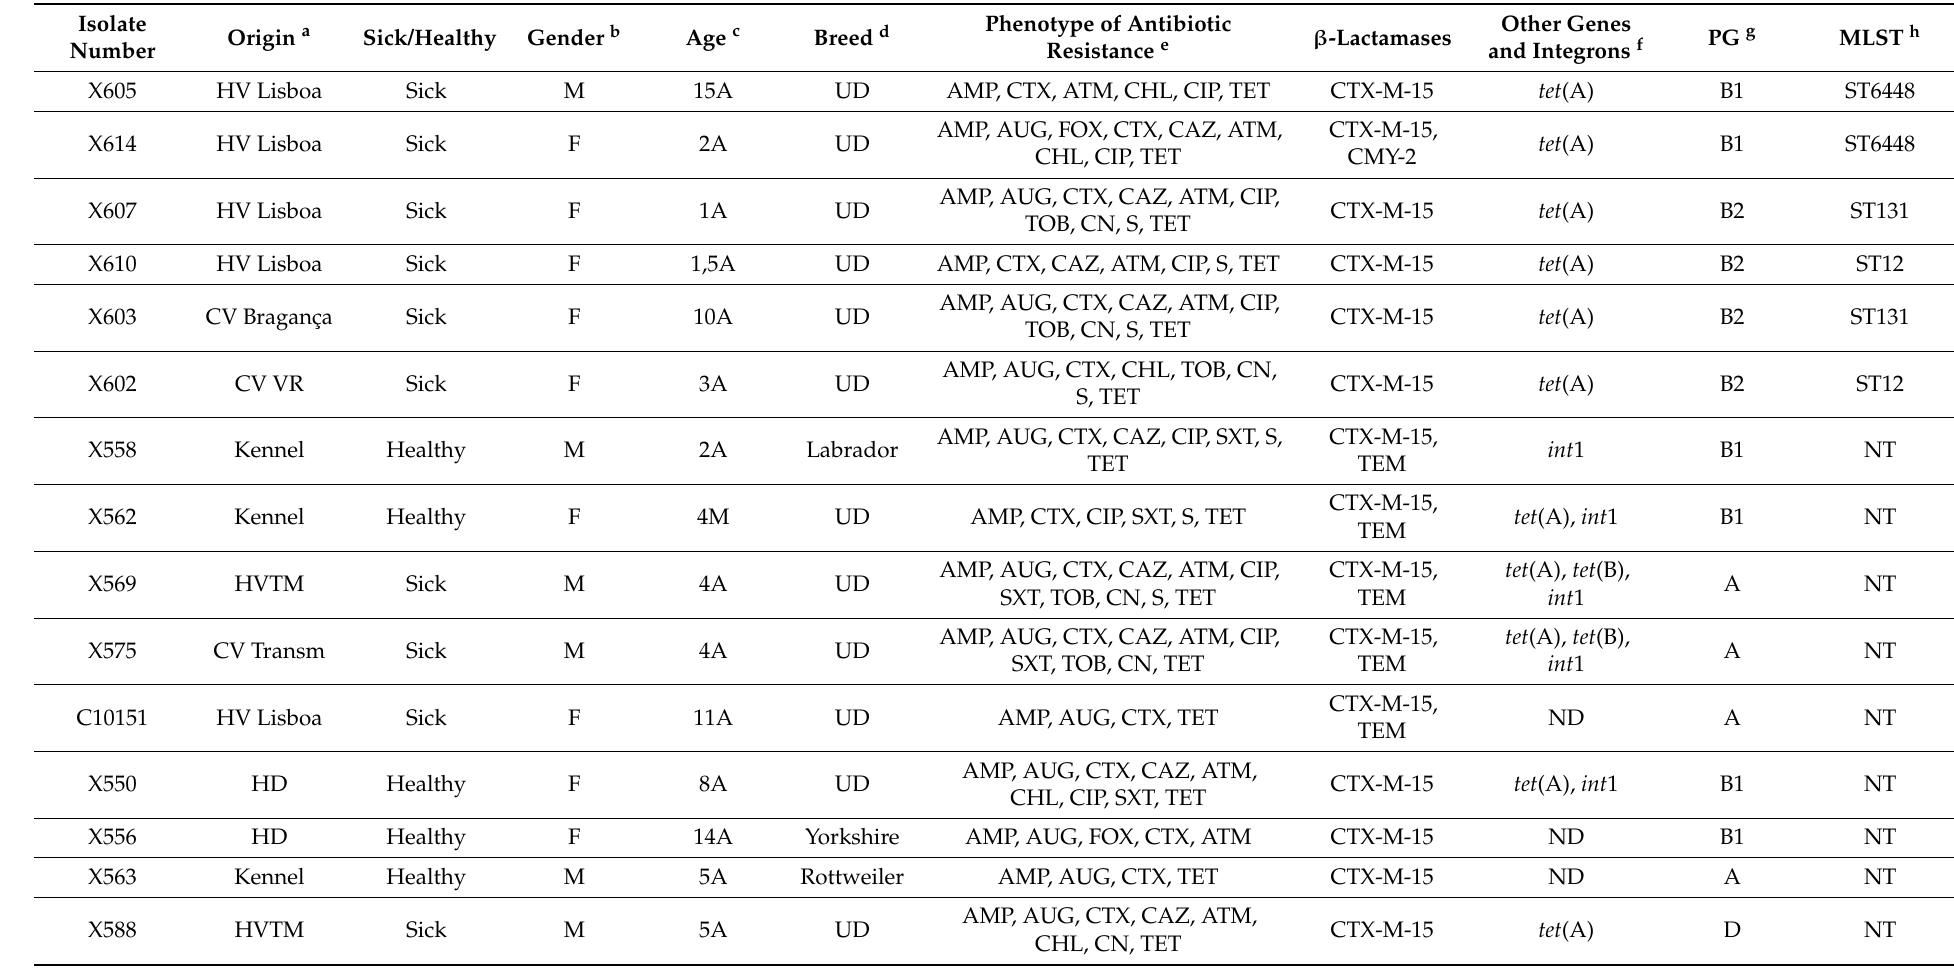
Table 1. Phenotypic and molecular features of the 47 ESBL-producing E. coli isolates recovered from healthy and sick dogs in Portugal.